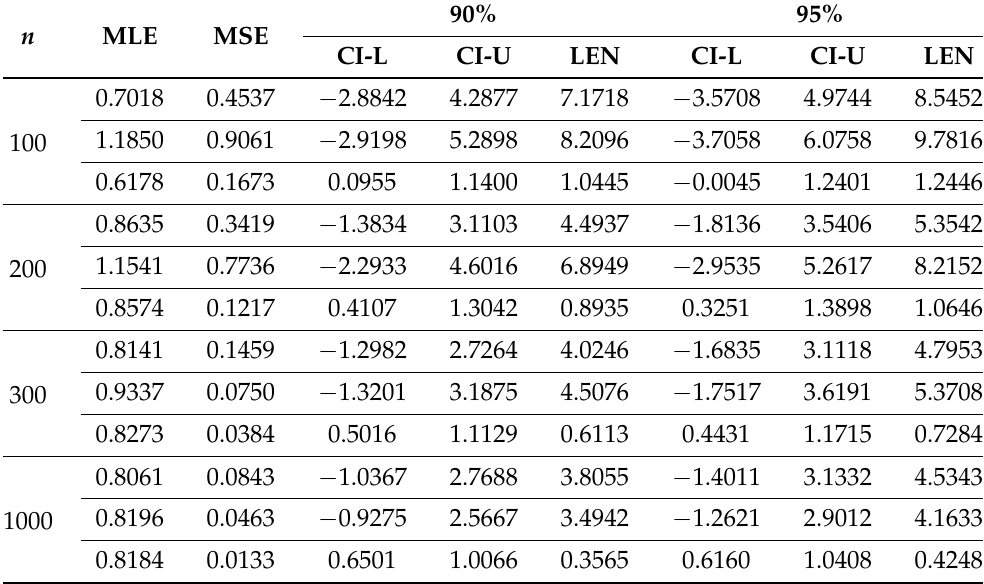
Table 6. Numerical values of the MLEs, MSEs, CI-Ls, CI-Us, and LENs for the parameters of the UG/G model for